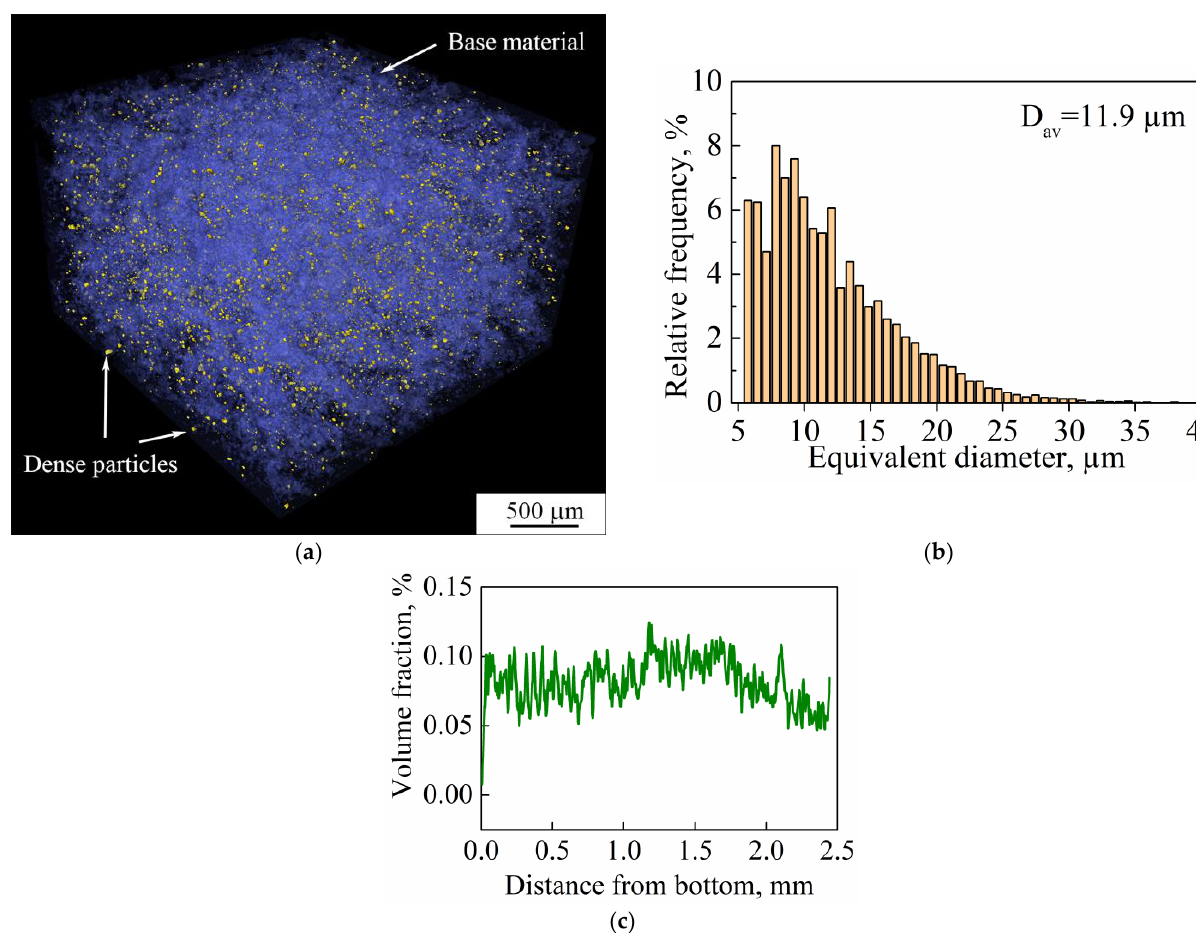
Figure 17. ( a ) Three-dimensional rendering of segmented phases (particles in yellow and base material in blue) in a porous sample; ( b ) the size distribution of dense particles; ( c ) distribution of the volume fraction of dense particles in the build direction of sample (D av is the average particle size).